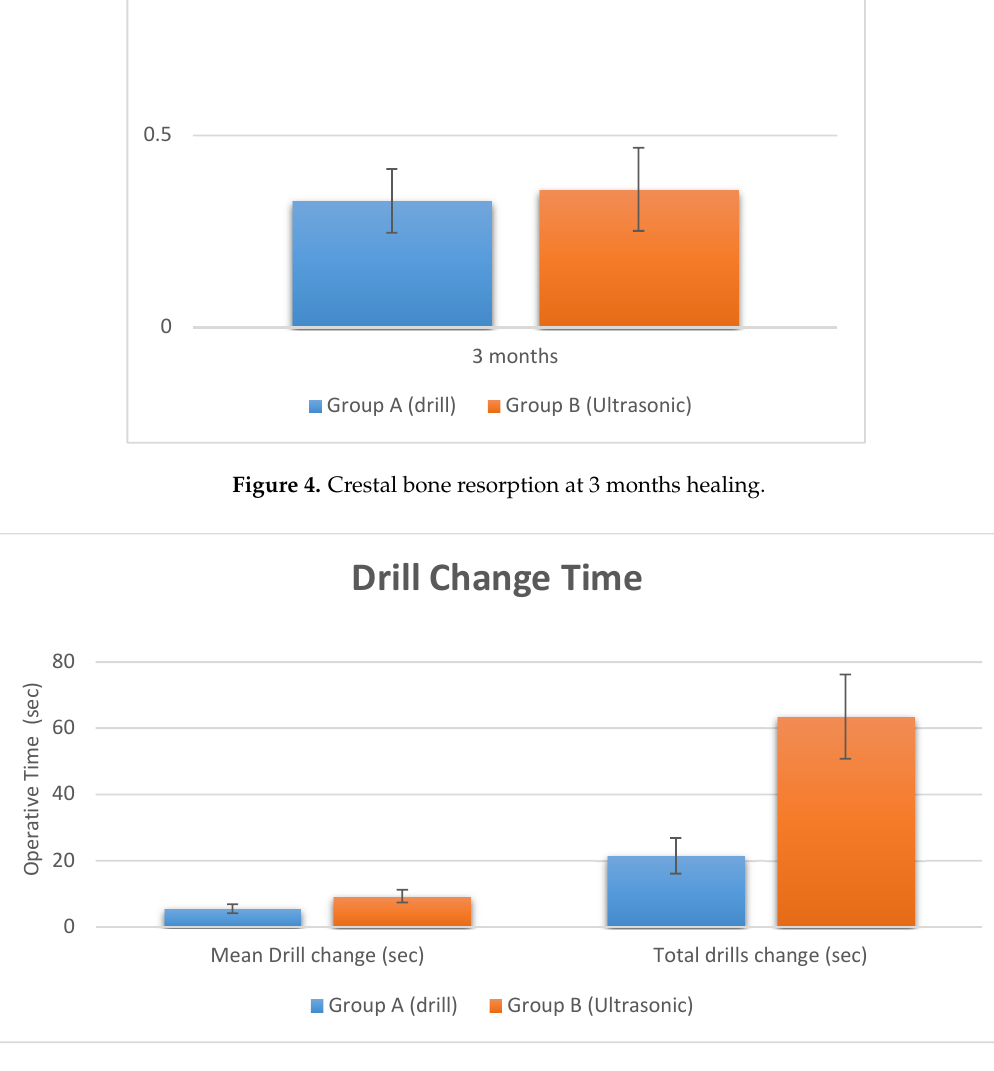
Figure 4. Drill change records of the two different site preparation techniques. Figure 5. Drill change records of the two different site preparation techniques. Table 2. Summary of operative time of implant site preparation. The crestal bone resorption was also evaluated at 3